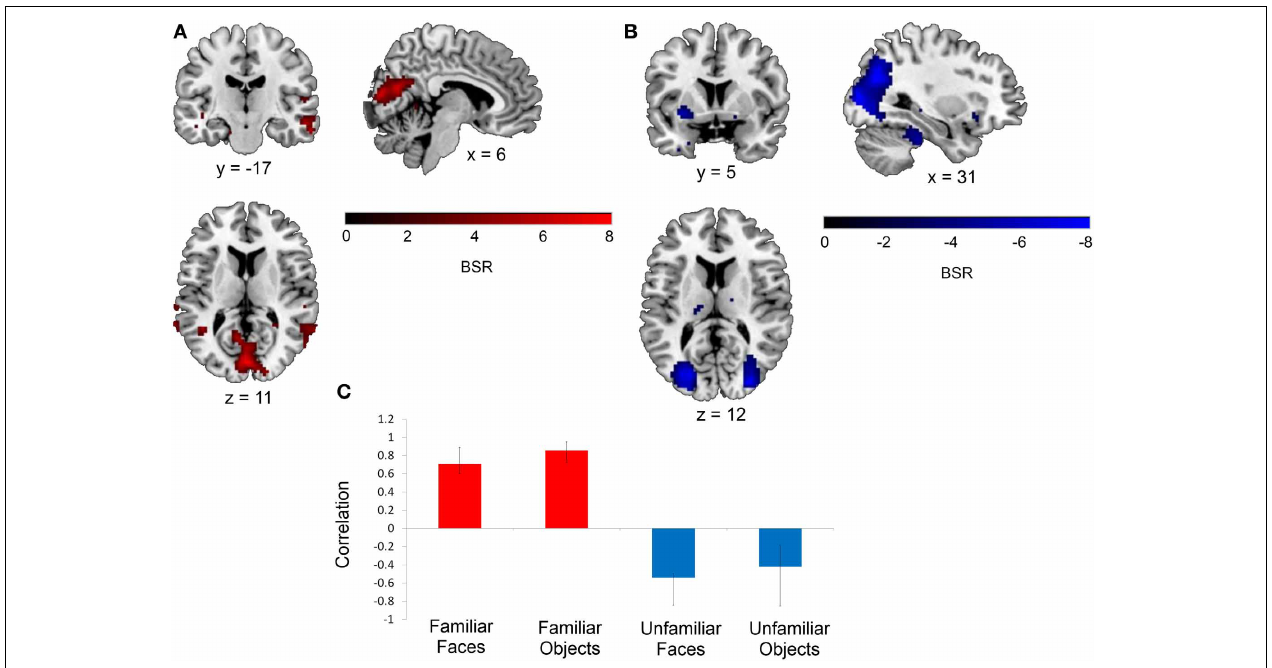
FIGURE 4 | Regions functionally connected with the right anterior hippocampal seed. The functional connectivity of the right anterior hippocampus also differed depending on stimulus familiarity. (A) Regions shown in red are those with which the right anterior hippocampal seed was functionally connected during the two familiar conditions in TR 3. (B) Regions shown in blue are those with pole ( x , y , z = 63 , 3 , − 18 , 8.94% of crossblock covariance, p